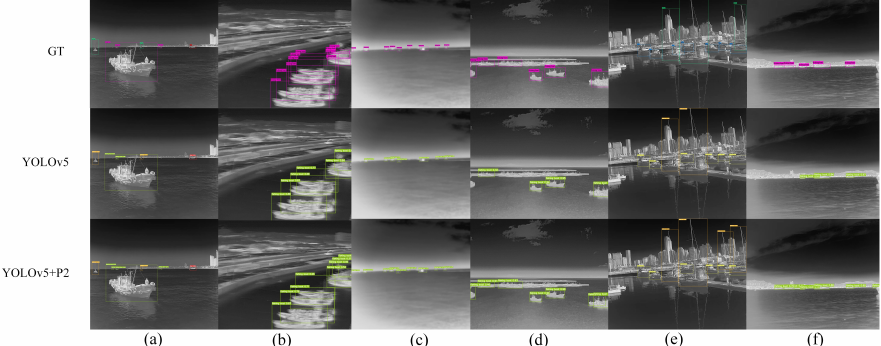
Figure 11. The infrared ship detection results of different methods. GT represents the ground truth box, YOLOv5 represents the original baseline network model and YOLOv5+P2 represents the addition of high resolution feature layer P2 based on YOLOv5; ( a – f ) represents the 6 groups of detection results obtained by using different